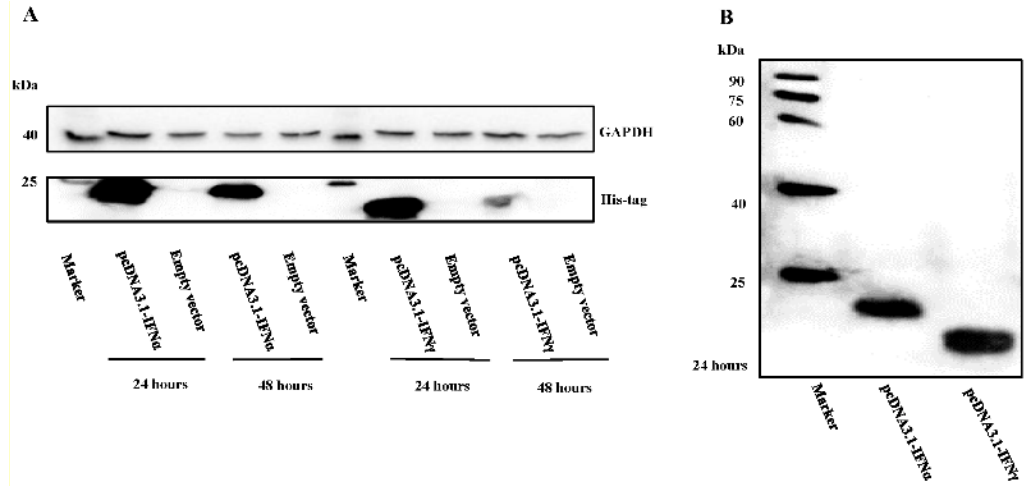
Figure 1. Western blot analysis of goose type I interferon (IFN α ) and type II interferon (IFN γ ) expression in Baby Hamster Syrian Kidney (BHK21) cells. ( A ) BHK21 cells were transfected with